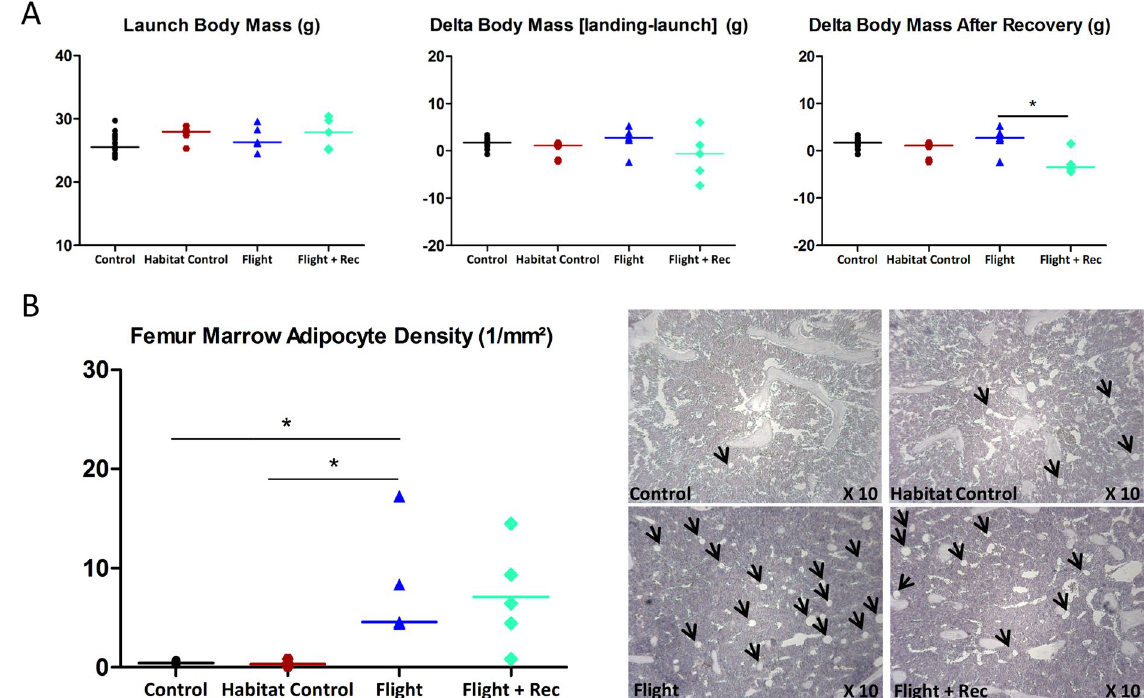
Figure 1. Effect of spacecraft housing conditions, spaceflight and recovery on ( A ) body mass, and ( B ) femur marrow adipocyte density (black arrows) in the metaphysis trabecular compartment (representative Haematoxylin/Eosin stained longitudinal sections). Data are presented as clusters of individual points (bars = median). * p < 0.017, ** p <